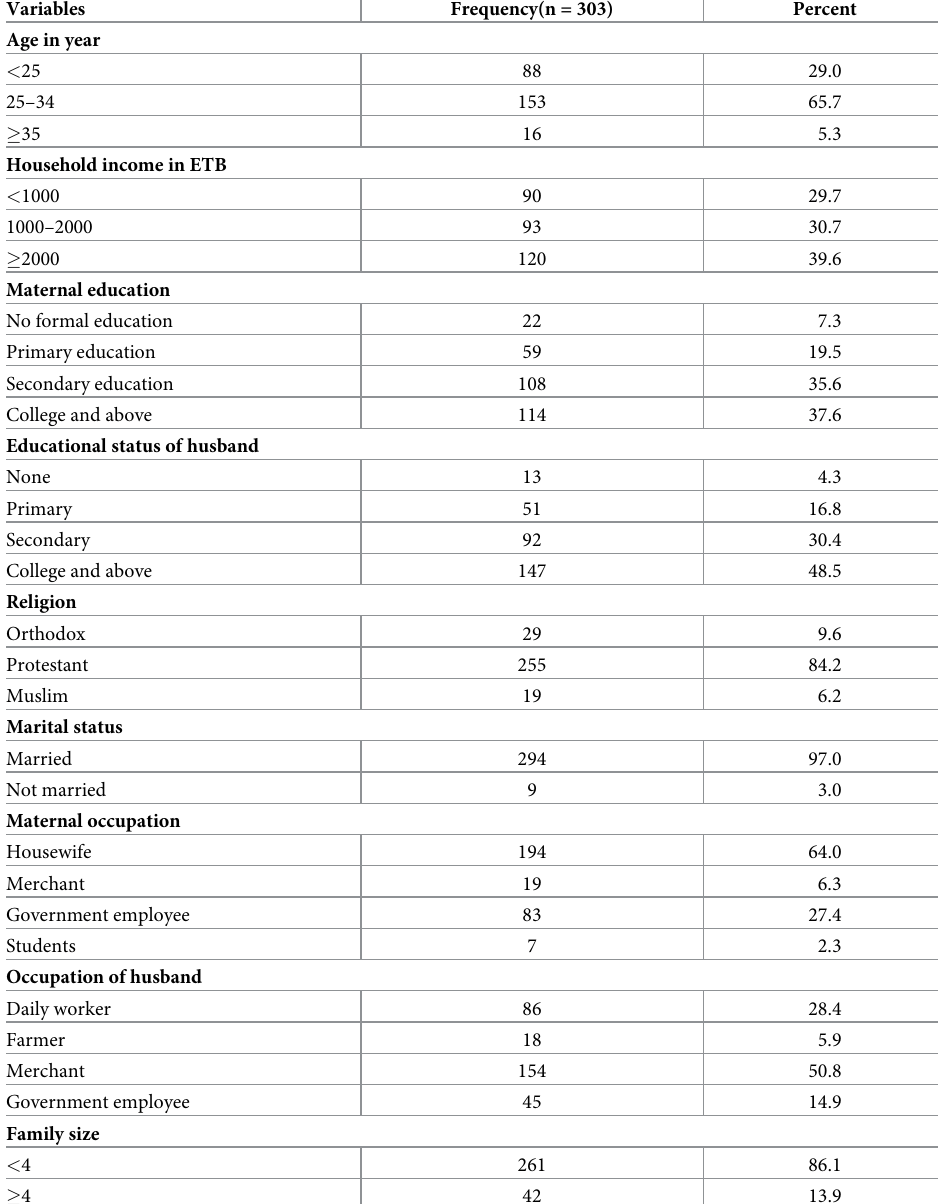
Table 1. Socio demographic characteristics of study participants in Wachemo University Nigist Eleni Mohammed Memorial referral hospital, 2019.